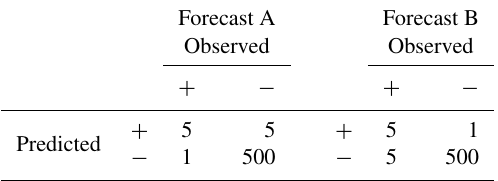
Table 6. Example of two forecasts (A, B) that agree on the correct predictions and the total number of false predictions but differ in the kinds of false predictions (Type I vs. Type